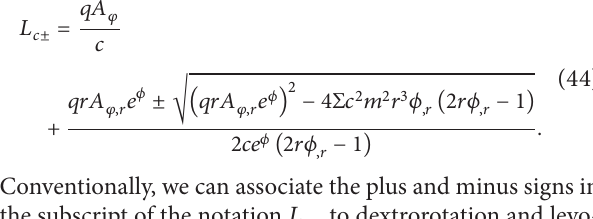
the solution 𝐸 ± = ±𝑚𝑐Φ 𝑚𝑐Φ 1/2 eff